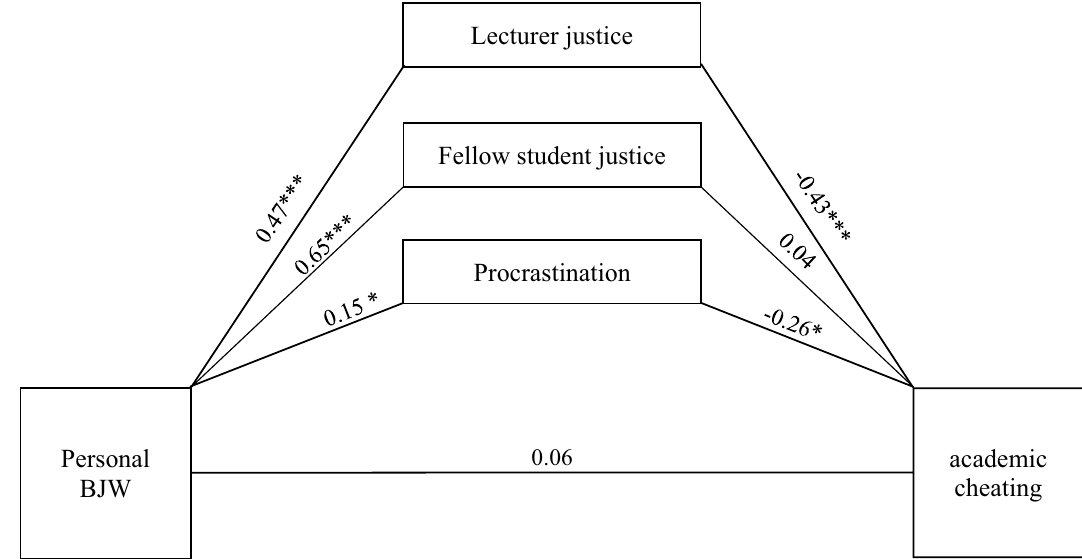
Figure 2. Mediation analysis of the relation between personal BJW and academic cheating considering the control variables. Total indirect effect of procrastination ( b = − 0.04), lecturer justice ( b = − 0.20) and fellow student justice ( b = 0.03) was: b = − 0.21, 95% CI [− 0.35; − 0.08]. Estimates are based on a bootstrapping procedure with 5000 bootstrap samples. *p < 0.05, ***p < 0.001. Used Process 77 Model 4. Direct effects on the paths. Values describe unstandardized path